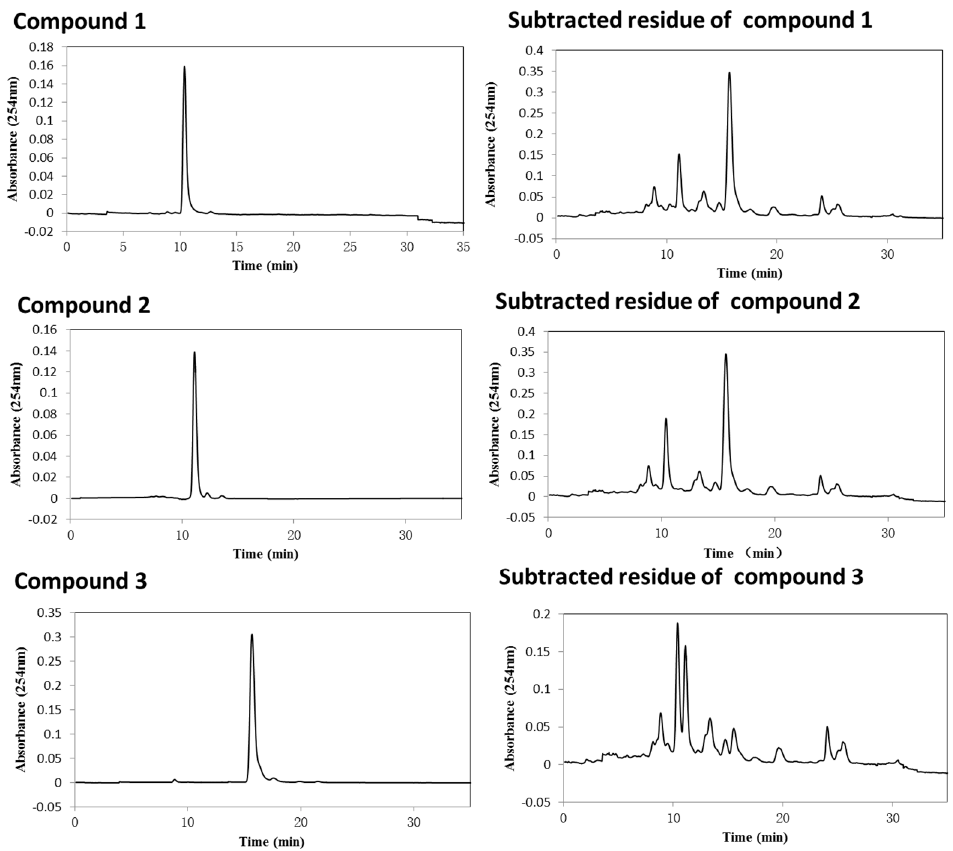
Figure 4. HPLC analysis of compounds 1 – 3 and their subtracted residues prepared by HSCCC.